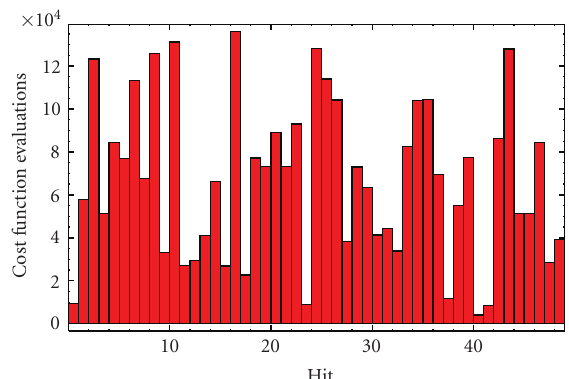
Figure 9: Histogram of SOMA algorithm: the number of cases in specific intervals of cost function